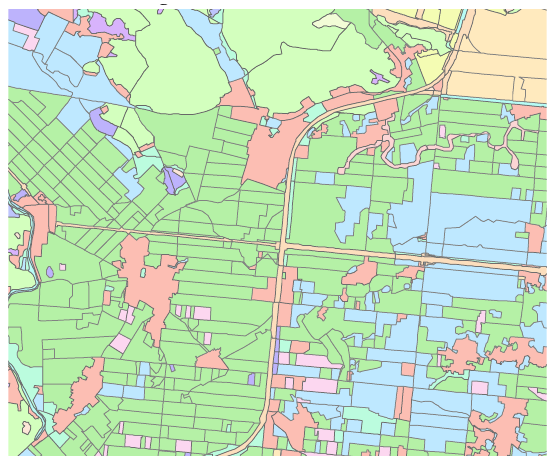
Figure 13. Part of the polygons in Hangzhou downtown.